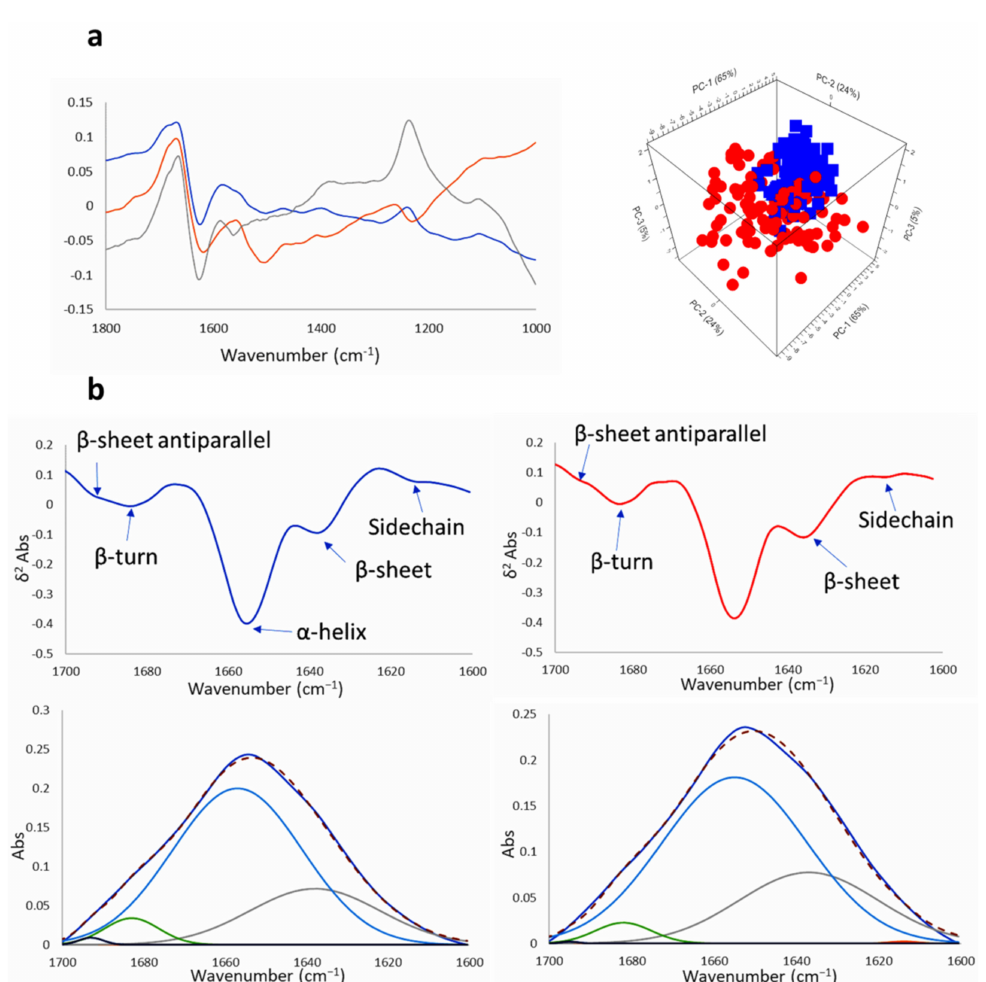
Figure 9. PCA and loadings within the protein region (1800–1000 cm − 1 ) of PG88 cells treated with Na[ o -COSAN] 200 µ M, 5 h: ( a ) Principal component loadings (blue PC-1, orange PC-2, grey PC-3) and principal components analysis scores plot of PC-1, PC-2 and PC-3 displaying the variance between PG88 control (blue) and PG88 treated cells (red). ( b ) The second derivative of FTIR spectrum at Amide I region 1700–1600 cm − 1 and its deconvolution is shown to visualize differences between PG88 untreated control (left) and PG88 treated cells (right). The deconvolutions follow the following code: Amide I-experimental in dark blue, Sidechain in orange, β -sheet in grey, α -helix in blue, β -turn in green, β -sheet antiparallel in black, and Amide I-calculated in red